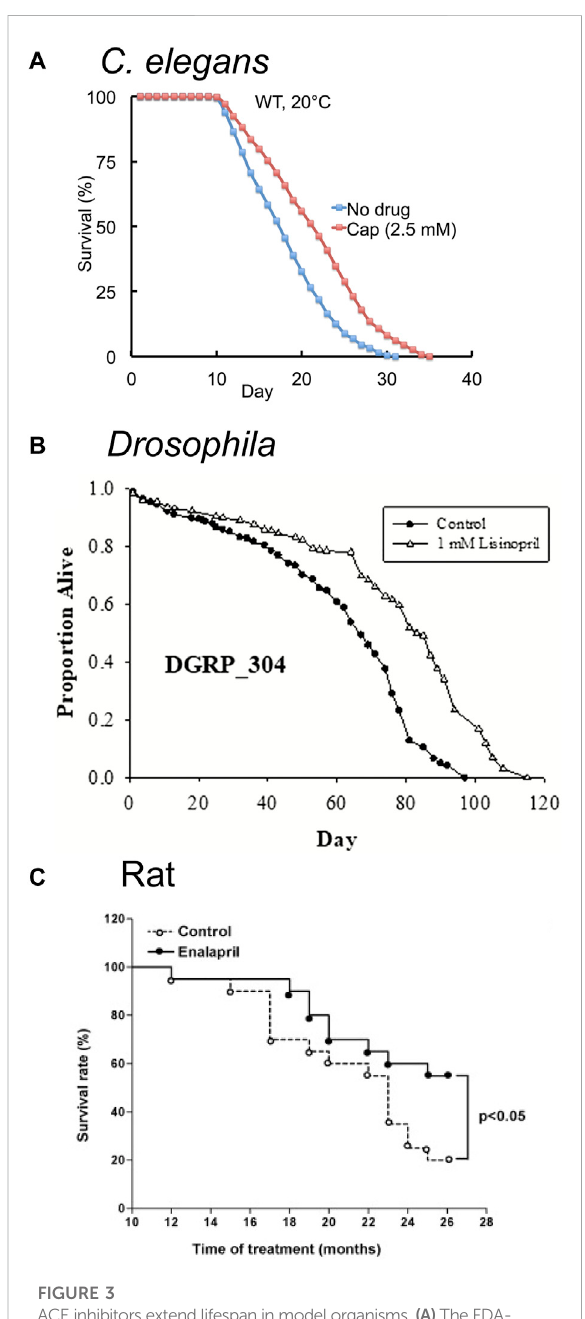
FIGURE 3 ACE inhibitorsextendlifespaninmodelorganisms. (A)